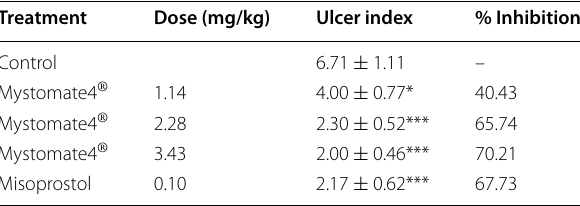
Results are mean SEM, n 7. Statistical comparison was determined by ± = one way ANOVA followed by Tukey’s multiple comparison tests. * P < 0.05, *** P < 0.001, statistically significant compared to control